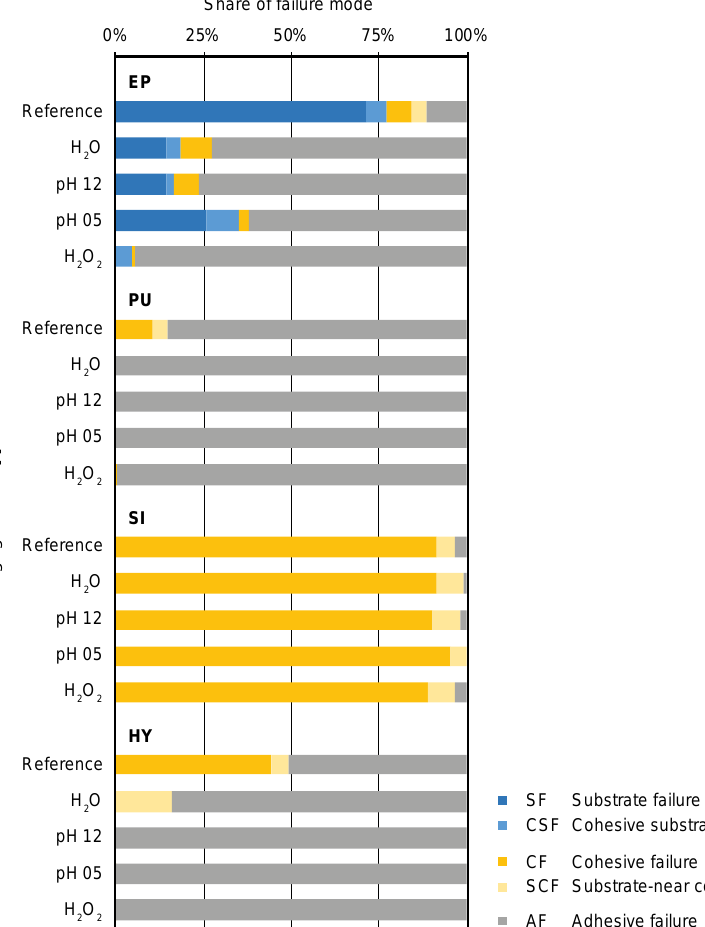
Figure 9: Failure modes after chemical aging.